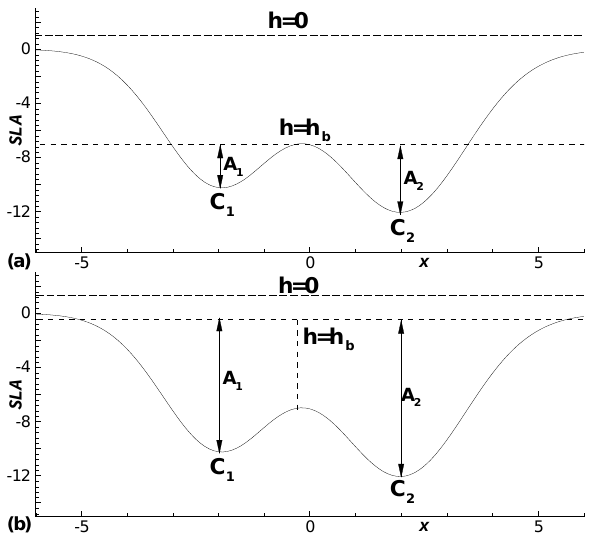
Figure 1. (a) Non-splitting mononuclear eddy identification. (b) Mononuclear eddy identification with splitting. Both the ampli- tude and the area are quite different in the two